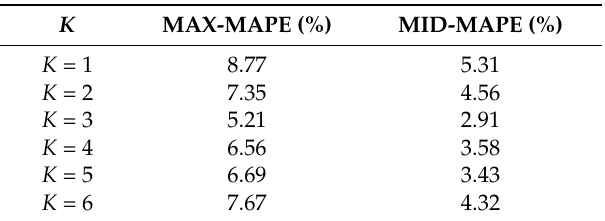
Table 2. The maximum and average MAPE of the load forecasting under different clustering conditions in experiment A.